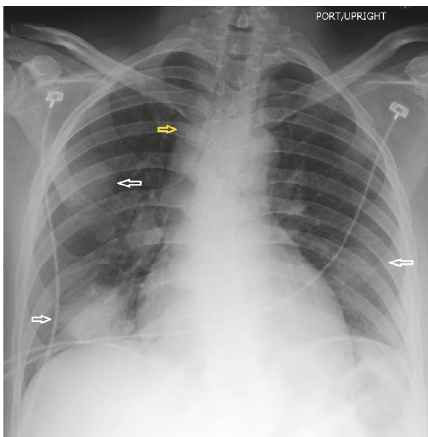
Figure 1: Chest X-ray: multiple bilateral pulmonary masses (white arrows) with right paratracheal lymphadenopathy (yellow arrow).